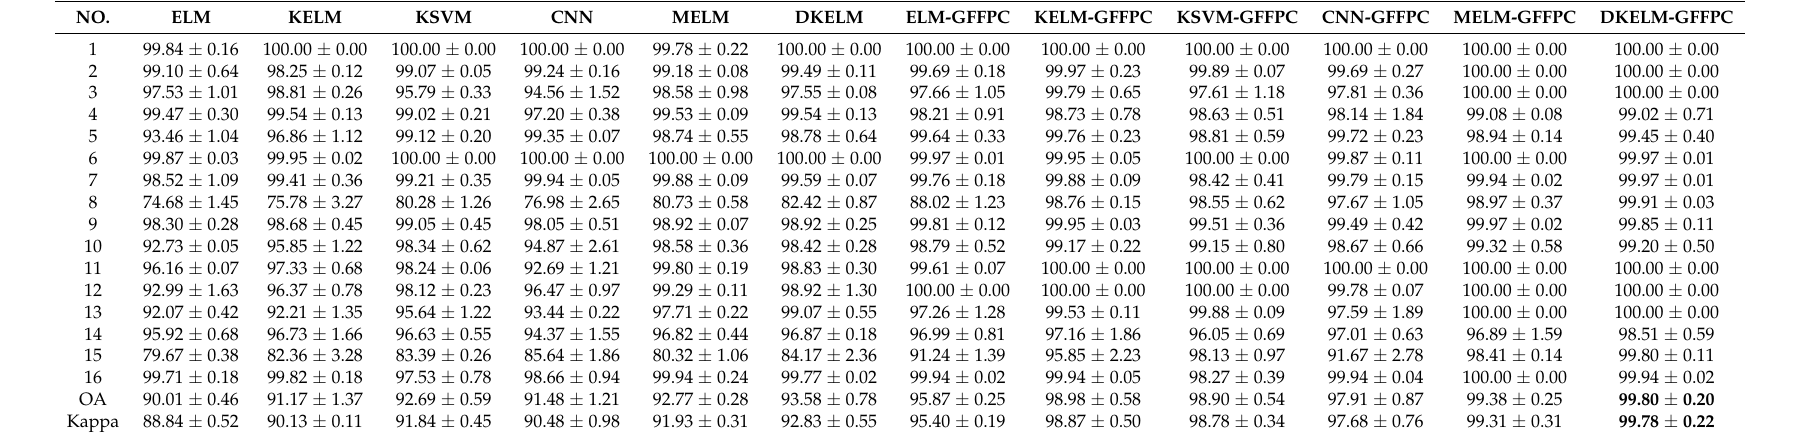
Table 7. Classification Accuracy(%) of the comparison and proposed algorithms in Salinas Dataset.